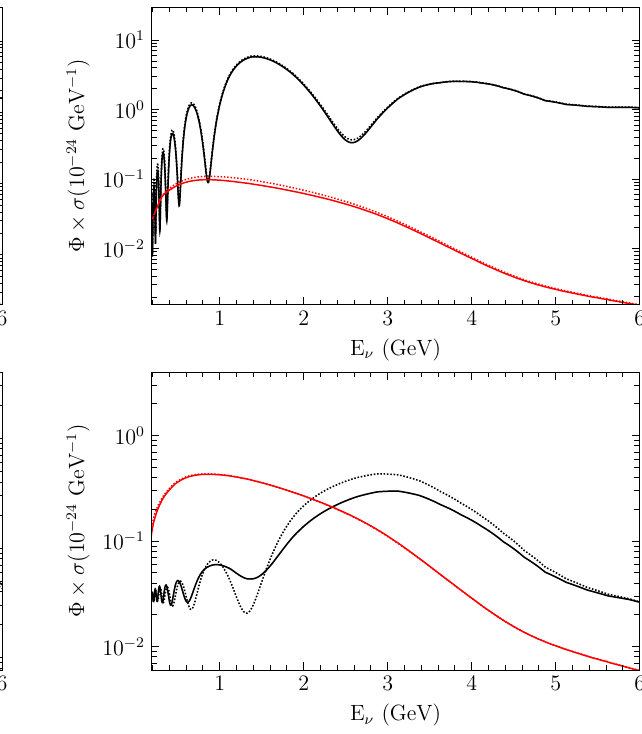
Fig. 1 ((cid:9) × σ) at the DUNE baseline, for ν μ disappearance (top) and ν e appearance (bottom) channels. The left (right) column shows results considering the FHC (RHC) flux. The black and red curves corresponds is consistent with our results in [46] for T2K, and shall also be relevant in the ν e appearance